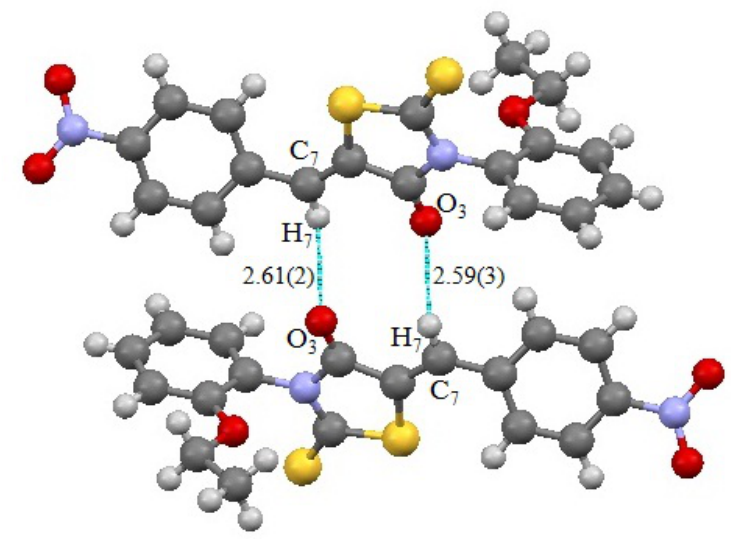
Figure 5. View of the two H-bonds C7-H7…O3 in the 2g